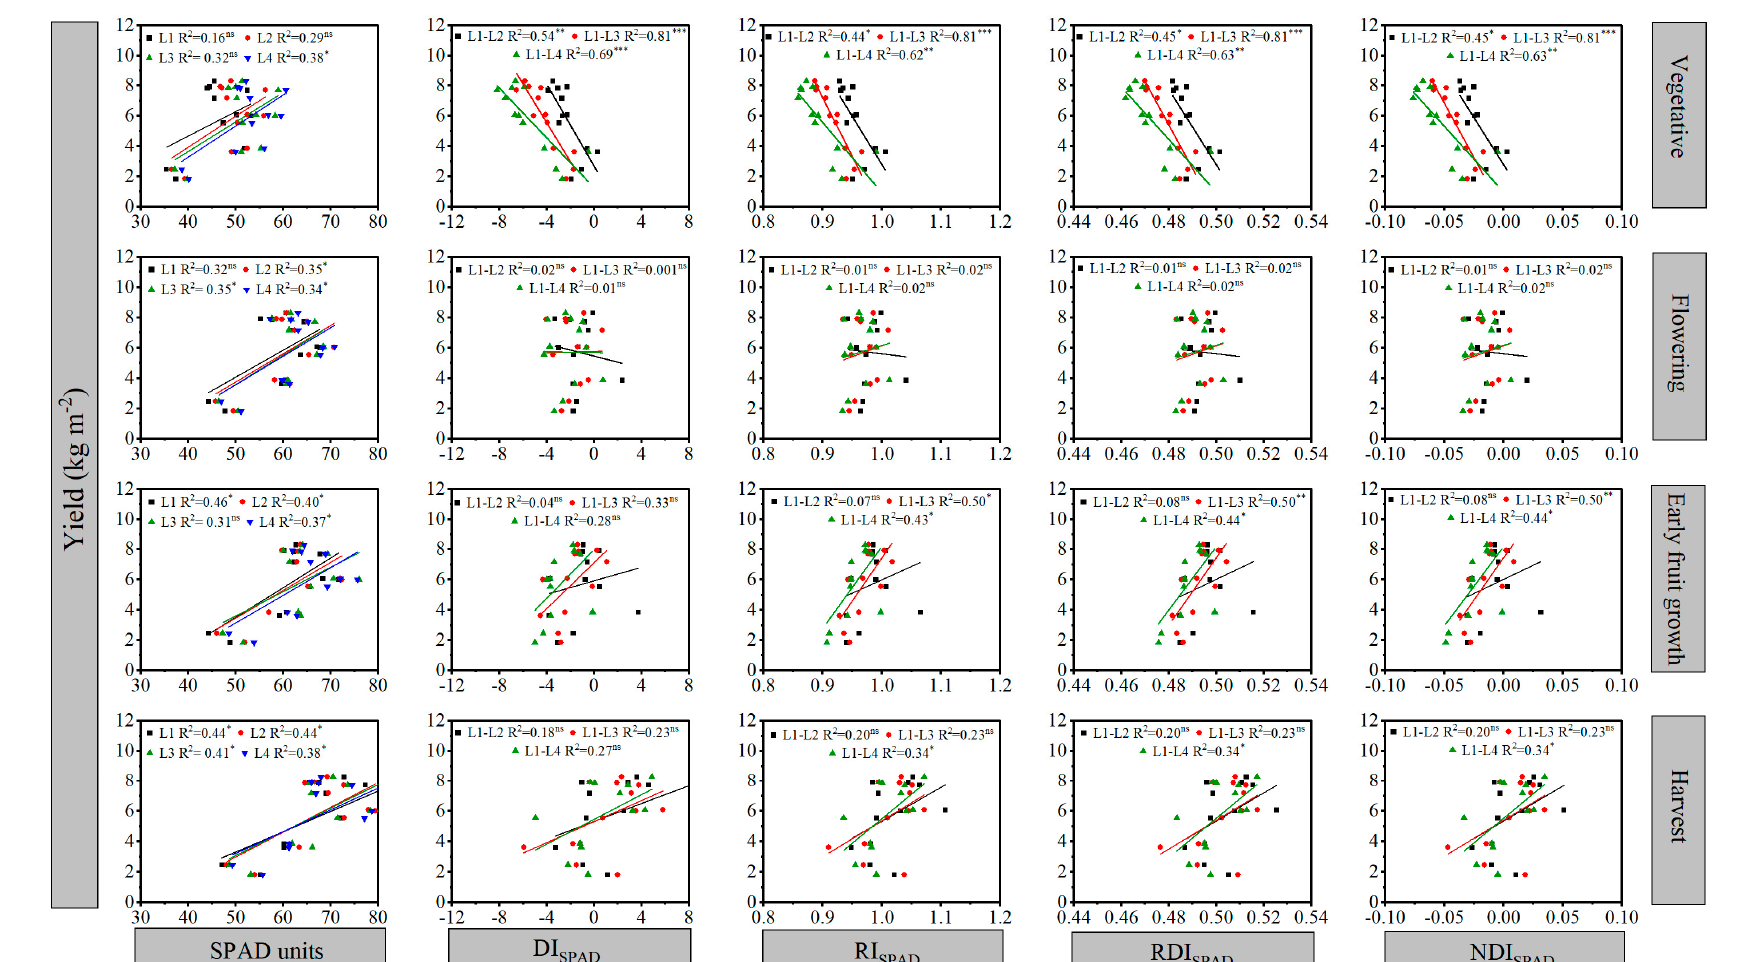
Figure 3. The relationships between absolute SPAD measurements and several normalized SPAD indices (DI, RI, RDI, NDI) with total fruit yield (kg m − 2 ) at different phenological stages of muskmelon, for calibration data. L1, L2, L3 and L4, refer to the latest (most recent) second, third and fourth fully expanded leaf, respectively. Asterisks show significance of regressions: ***, p < 0.001; **, p < 0.01; *, p < 0.05; ns, p > 0.05.